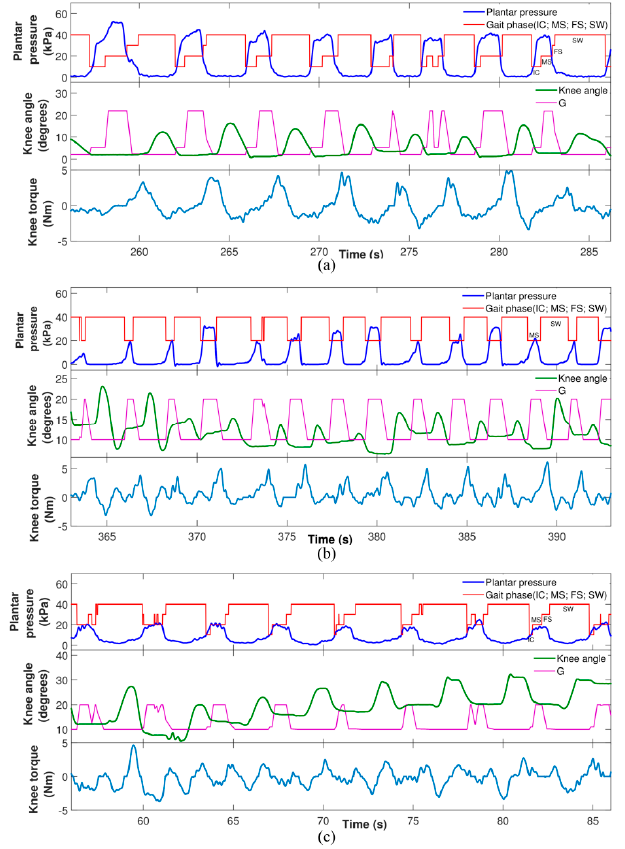
Figure 2. Example of acquired signals from the patients: plantar pressure, gait phase, gain variation (G), knee angle and knee torque. IC, initial contact; MS, mid stance; FS, final stance; SW, swing. ( a ) signals from P1; ( b ) signals from P2; ( c ) signals from P3.